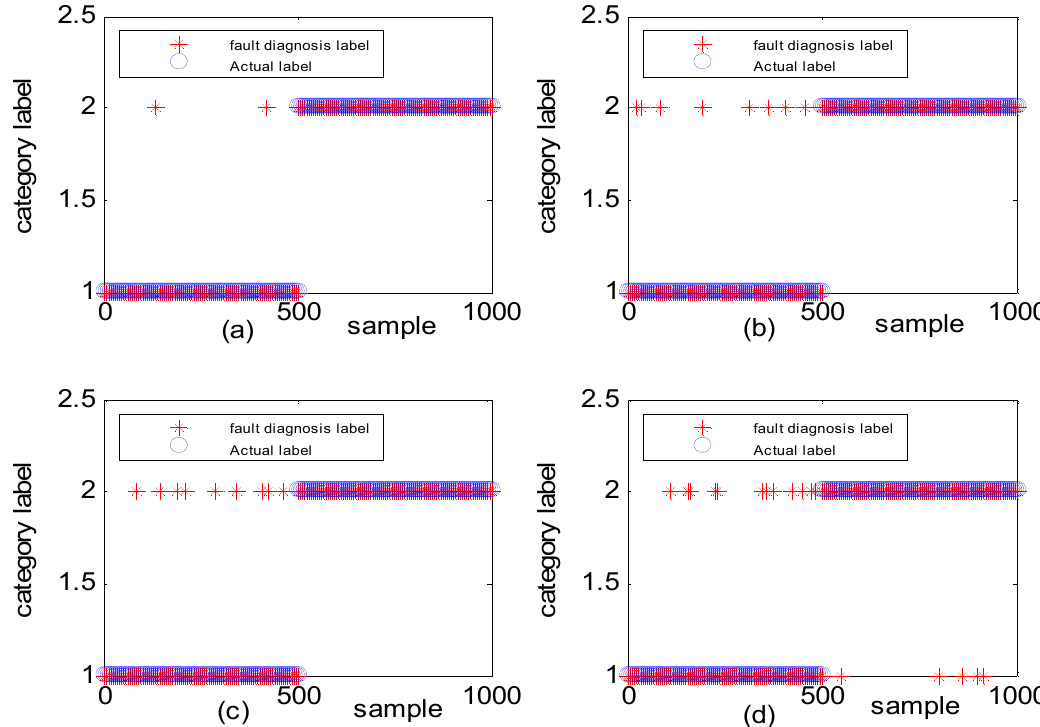
Figure 11. Simulation results for diagnosis of fault with different fault amplitudes and different fault frequencies: ( a ) DGFFDNN, ( b ) DNN, ( c ) DGFFBP, and ( d ) BP. A red star represents the fault diagnosis label of each online sample, and a blue circle represents the real label of each sample. At each sample time, the coincidence of a red circle and a blue star means that the online observation at this sample time is correctly diagnosed.